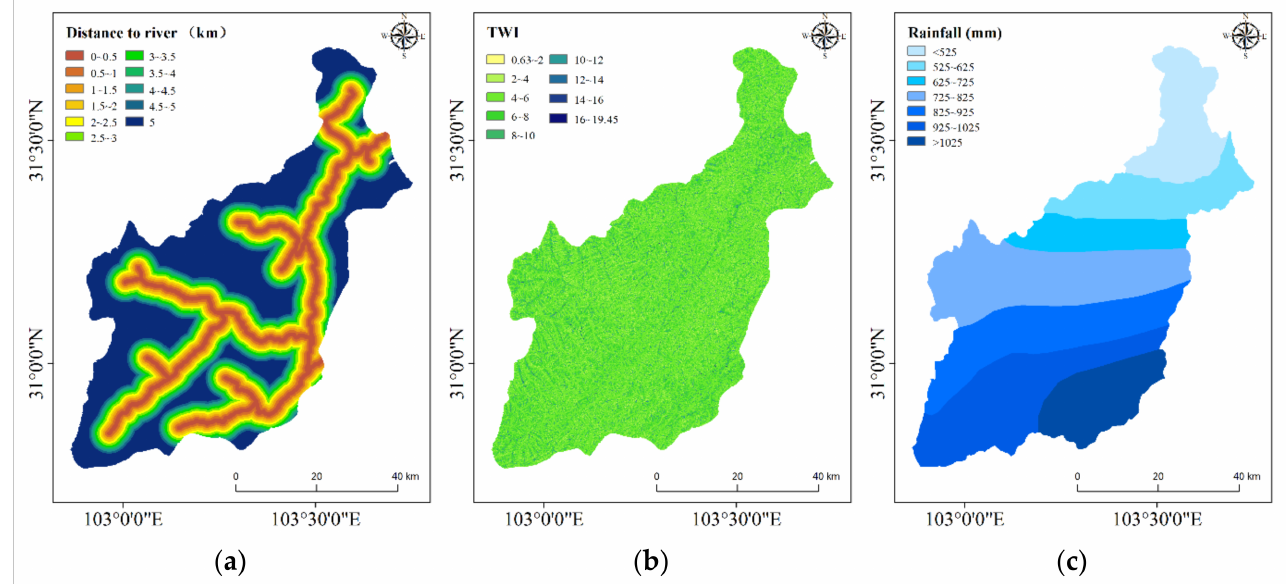
Figure 6. Hydrological-related causative factors. ( a ) Distance to river; ( b ) TWI; ( c ) Rainfall. Topographic wetness index (TWI): TWI represents the spatial distribution of water in the soil and can describe the topographic influence on the water saturation of the soil. The moisture content in the soil will affect the rock, soil, and vegetation conditions on the slope surface, thereby affecting the landslide occurrence. The study area was divided into 9 sets at 2 intervals according to the range of the TWI; see Figure